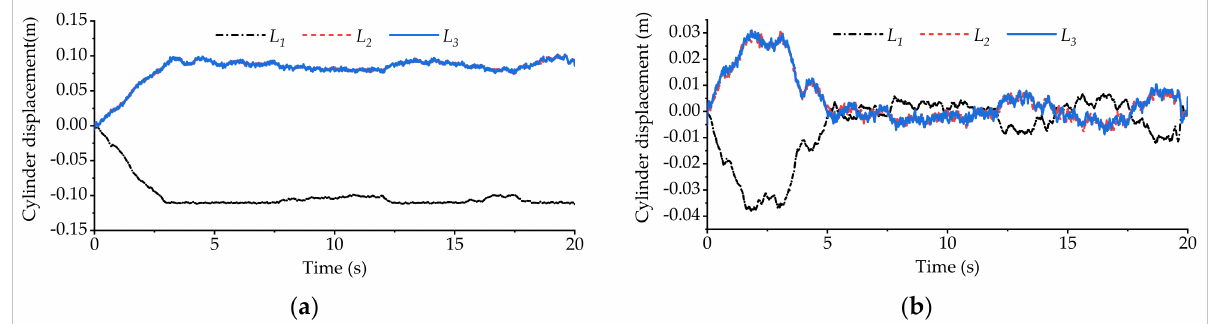
Figure 19. The displacement of equivalent suspension servo actuator cylinder when only pitch angle is used as input in the longitudinal slope experiment: ( a ) displacement of equivalent suspension servo actuator cylinder without high-pass filter; ( b ) displacement of equivalent suspension servo actuator cylinder when high-pass filter is